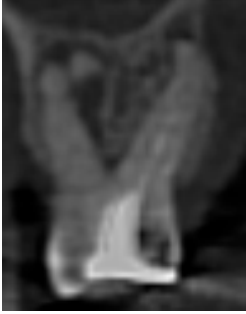
Figure 7. P—the teeth with periapical lesion.